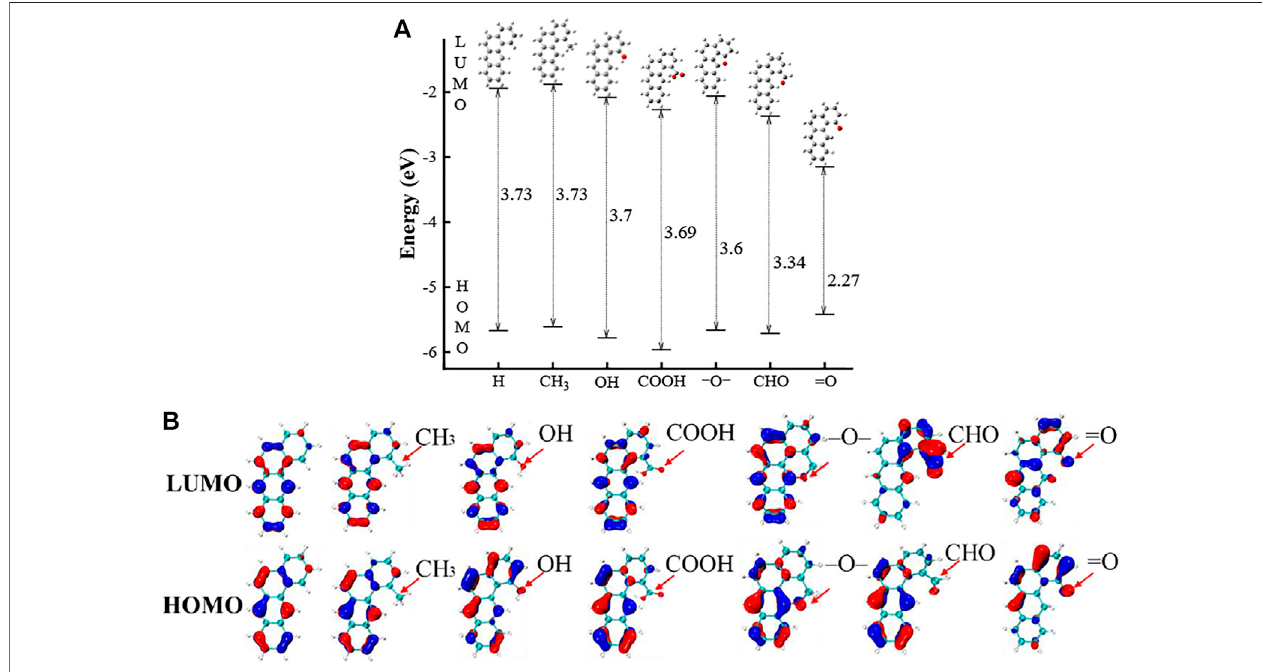
FIGURE3|(A) HOMOandLUMOenergiesofafour-ringPAHwithandwithoutsixfunctionalgroups. (B) TheHOMOandLUMOelectronicstructuresofPAHswith “– OH ” , “– CHO ” , “– COOH ” , “ (cid:1) O ” , “– O –” groups.